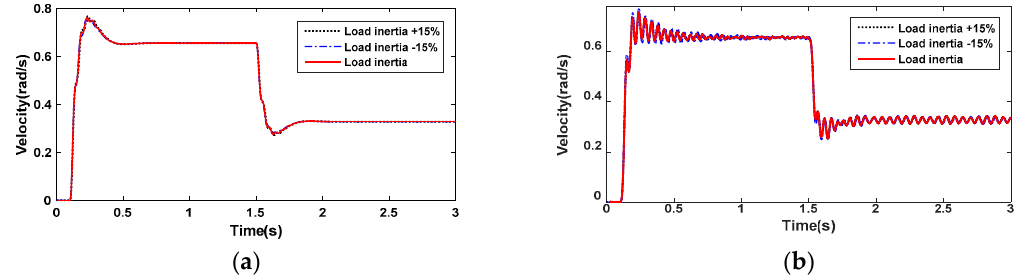
Figure 16. Robust performance to load inertia ± 15% changes with link-side controller: ( a ) simulations; ( b ) experiments.